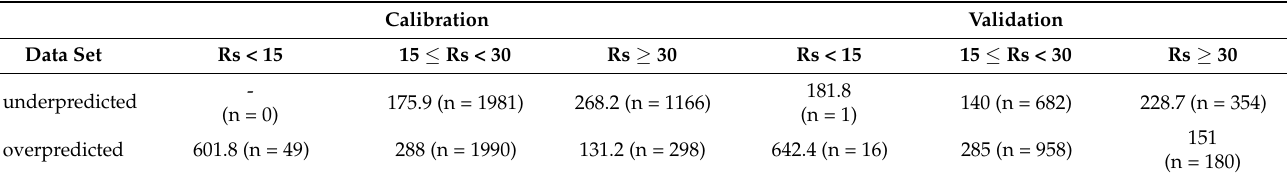
Table 17. RMSE values (J · cm − 2 · day − 1 ) and number of data points belonging to under- and overestimation sets in three defined intervals of measured solar radiation (MJ · m − 2 · day − 1 ) for calibration and validation phases using proposed